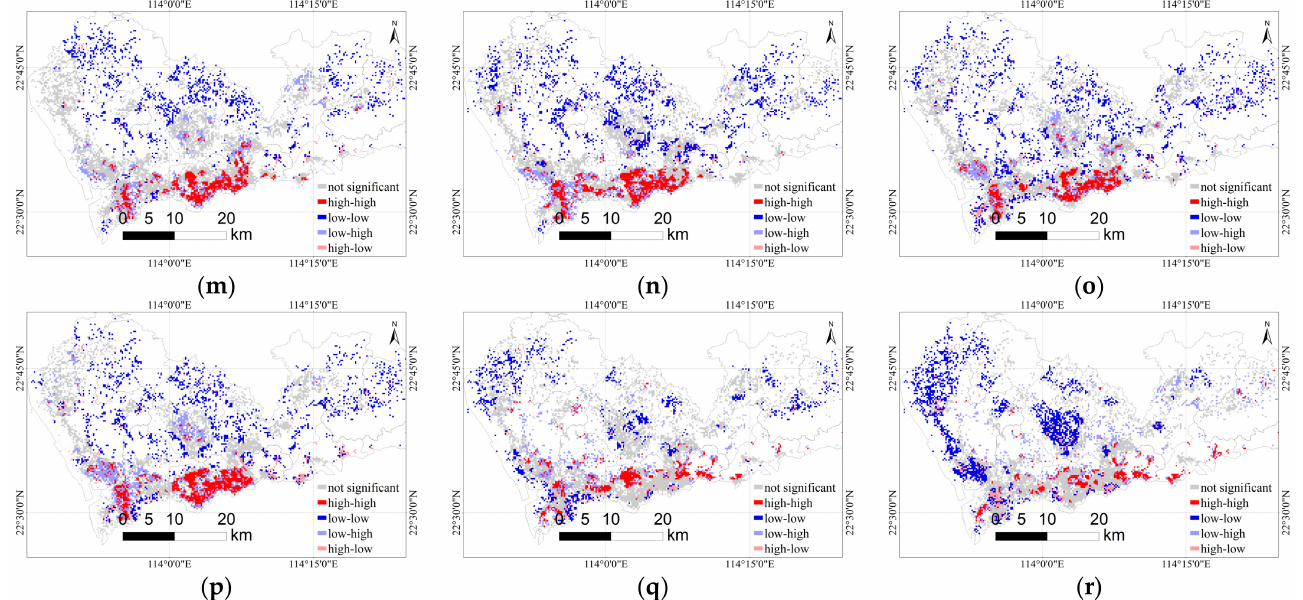
Figure 5. The BiLISA spatial clustering maps of recreation trips to parks with built environment variables. ( a – f ) Spatial clustering characteristics of Group 1 with the average building height, road density, POI diversity, population density, average tree height, and the mean value of EVI. ( g – l ) Spatial clustering characteristics of Group 2. ( m – r ) Spatial clustering characteristics of Group